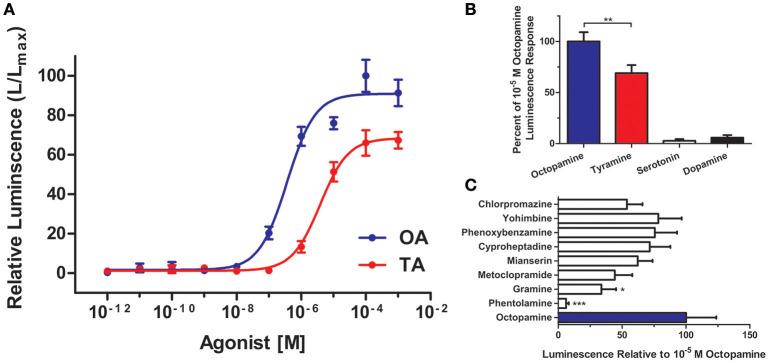
Functional characterization of R. prolixus Octβ2 receptor in HEK293 cells. (A) Dose-response curve showing the effects of octopamine (OA) and tyramine (TA) on RhoprOctβ2-R. (B) RhoprOctβ2-R is selective for octopamine and tyramine, while serotonin and dopamine are inactive against the receptor. (C) The effects of various biogenic amine antagonists on RhoprOctβ2-R. Phentolamine and gramine significantly reduced octopamine-induced receptor activation (One-Way ANOVA followed by Dunnett's Multiple Comparison Test compared to octopamine groups at 100%, *P < 0.05, **P < 0.01, ***P < 0.001). All receptor agonists and antagonists were tested at 10−5 M. Data represent the mean ± SEM of n = 5–6 per treatment.